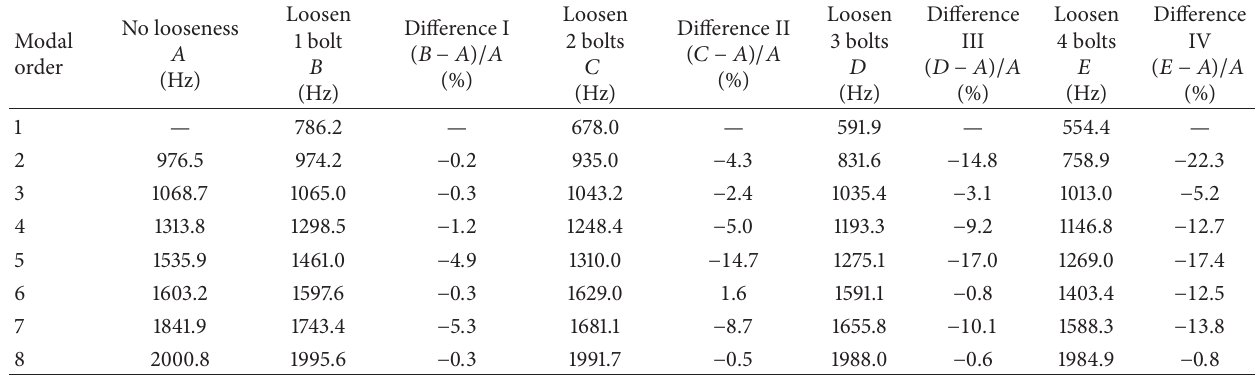
Table 2: Natural frequencies of TCS under BLB with different looseness numbers.